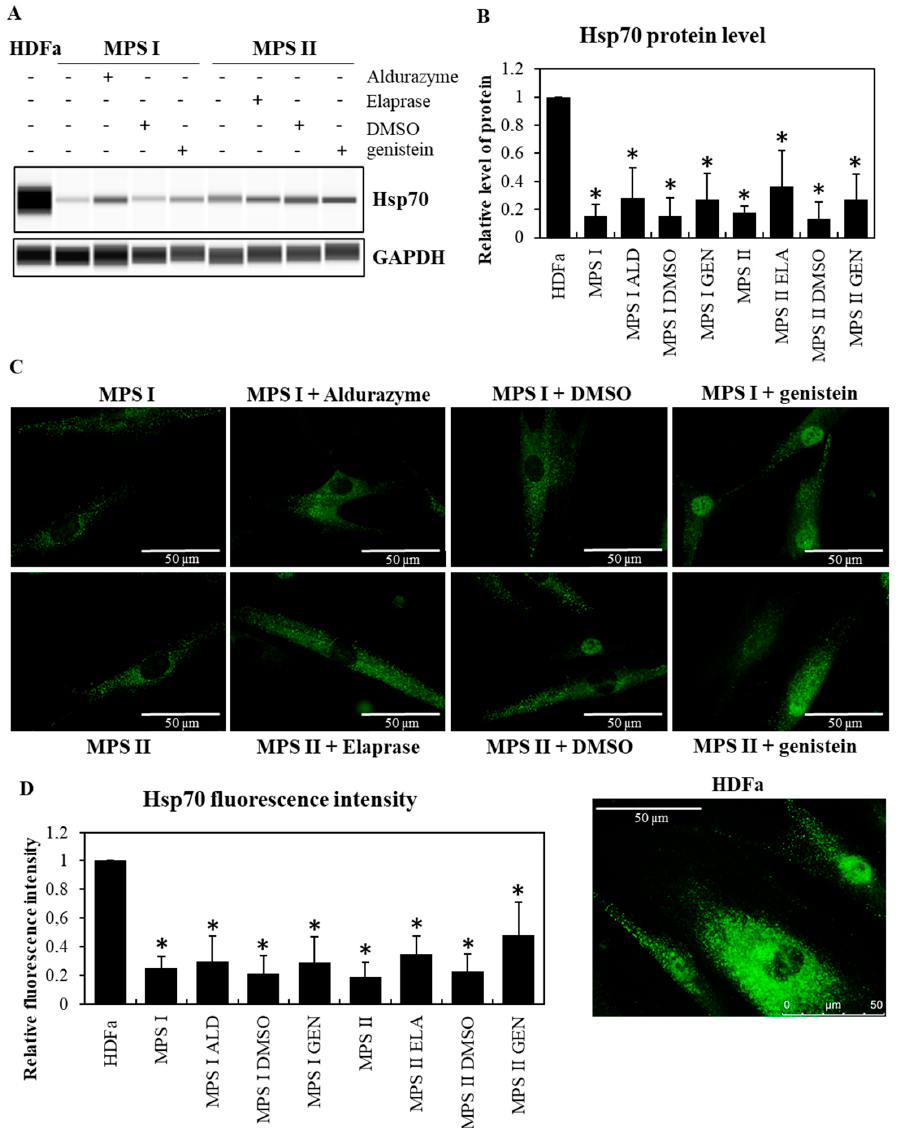
Figure 1. Decreased levels of Hsp70 in MPS cells and effects of ERT and SRT. Western blotting ( A , B ) and immunofluorescence ( C , D ) analyses of the abundance of Hsp70 in MPS I and MPS II fibroblasts, relative to HDFa control cells, either non-treated (minuses) or treated (pluses) with Aldurazyme (ALD, recombinant α -L-iduronidase) at 0.58 mg/mL, Elaprase (ELA, recombinant 2- iduronate sulfatase) at 0.5 mg/mL, DMSO (solvent for genistein) at 0.05%, or genistein (GEN) at 50 µ M for 24 h. Panel ( A ) shows a representative Western blot (with GAPDH as loading control) while panel ( B ) demonstrates quantitative analyses (based on densitometry) from 3 independent experiments, with error bars representing SD. Panel ( C ) shows representative fluorescent microscopic pictures (with scale bars indicating 50 µ m), while panel ( D ) demonstrates quantitative analyses (relative fluorescence intensity) from 100 randomly chosen cells of each variant of the experiment. In panels ( B ) and ( D ), asterisks indicate statistically significant differences (at p < 0.05 in two-way ANOVA and post hoc Tukey’s test) relative to HDFa cells. No statistically significant differences were detected between non-treated and treated MPS I or MPS II